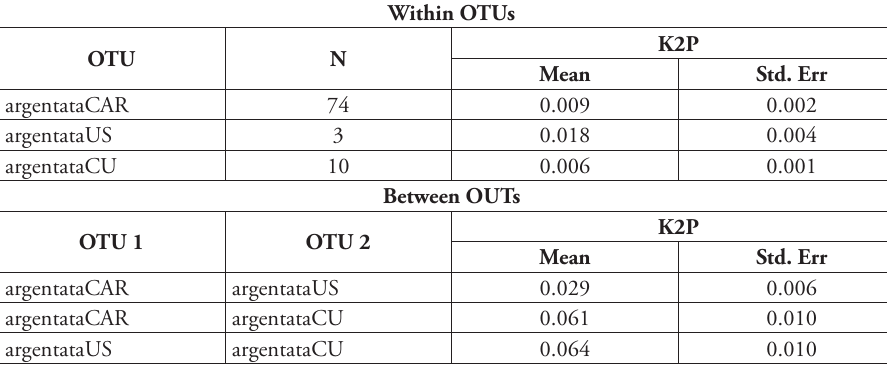
Table1. Descriptive statistics for K2P (Kimura 2-parameter) distances within and between the molecular operational taxonomic units (OTUs), which were identified by molecular species delimitation